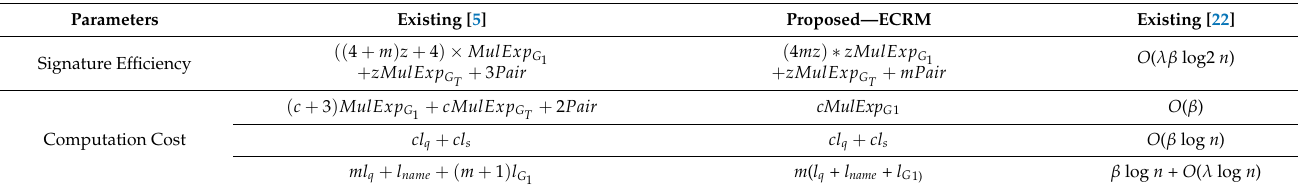
Figure 5. Decryption time. Table 1. Comparison of the proposed with the existing